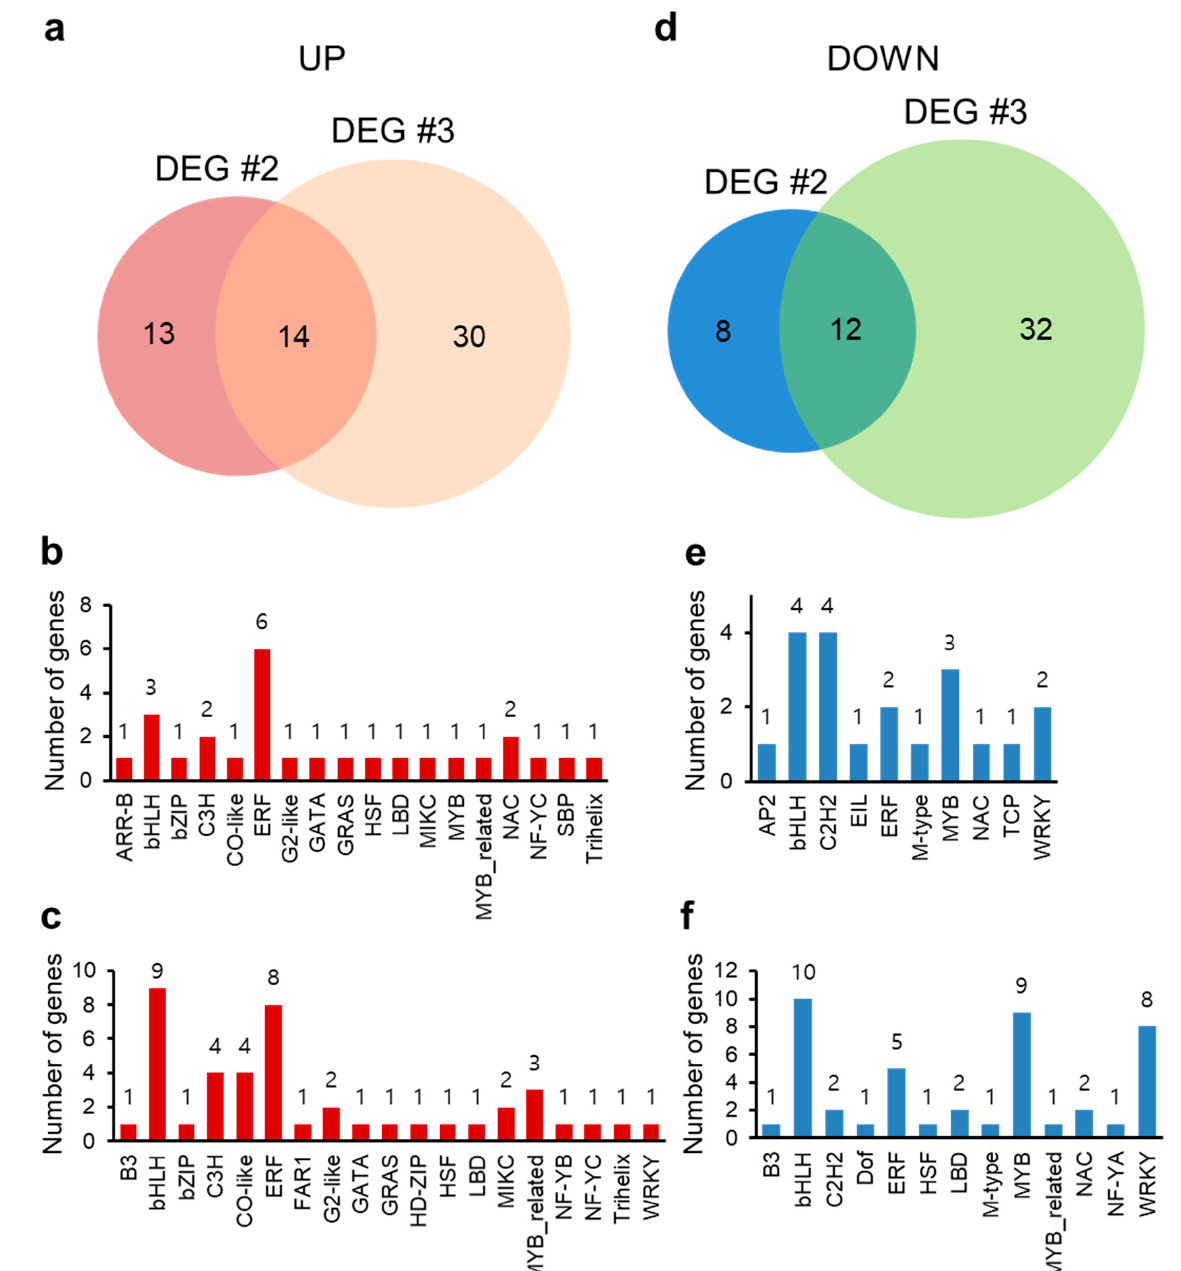
Figure 6. Number of up- or down-regulated transcription factor genes in DEG #2 and DEG #3. The number of TF genes significantly up- ( a – c , log 2 fold change ≥ 1) or down- ( d – f , log 2 fold change ≤ − 1) regulated in DEG #2 ( d , e ) and DEG #3 ( c , f ) represented as a Venn diagram ( a , d ) or a bar graph ( b , c for up-regulated TF genes; e , f for down-regulated TF genes). Twenty TF genes were down-regulated by HA in DEG #2, and 44 TFs in DEG #3 (Figure 6d–f and Additional file 2). Genes encoding Myb domain-containing TFs PAP1,